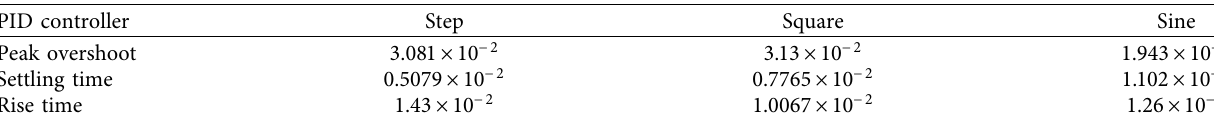
Table 2: PID output